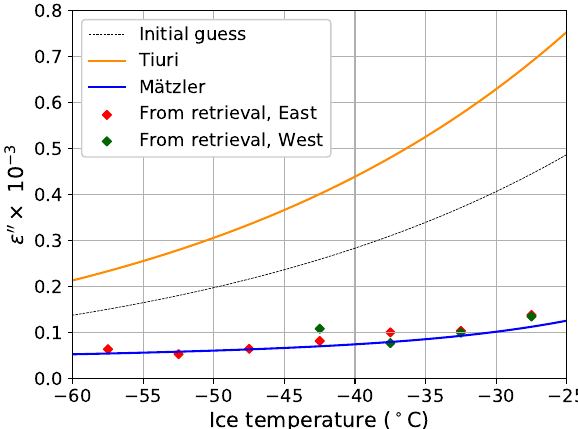
Figure 5. Imaginary part of ice permittivity computed from the Tiuri (orange) and Mätzler (blue) models, depending on ice temperature. The dashed line shows the initial guess of the retrieval process. The result of the retrieval is shown with red (East Antarctica) and green (West Antarctica) diamond